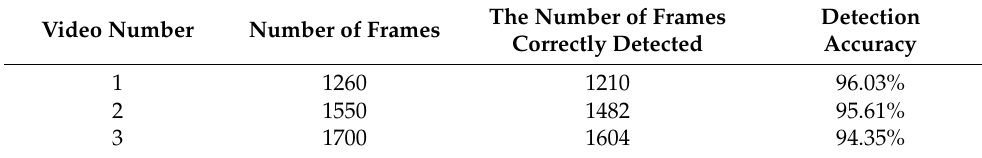
Table 4. Test results of this